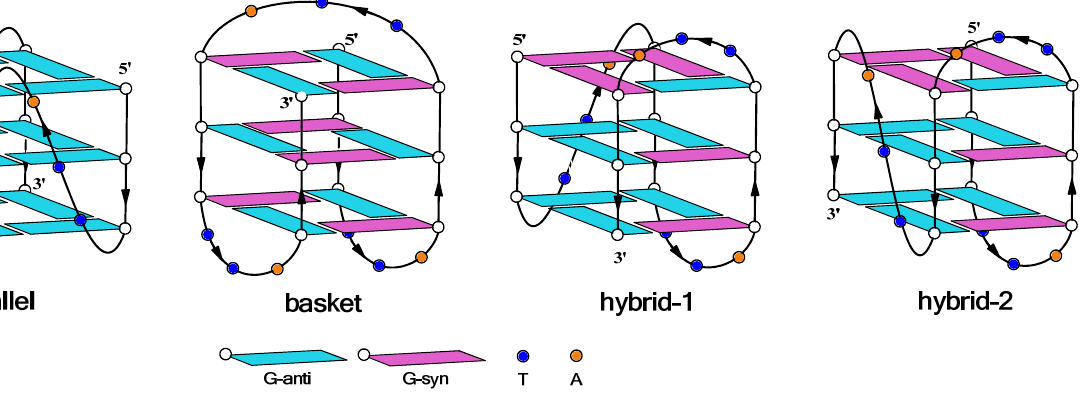
Figure 1. Schematic representation of G-quadruplex topologies formed by HT21 in different buffer